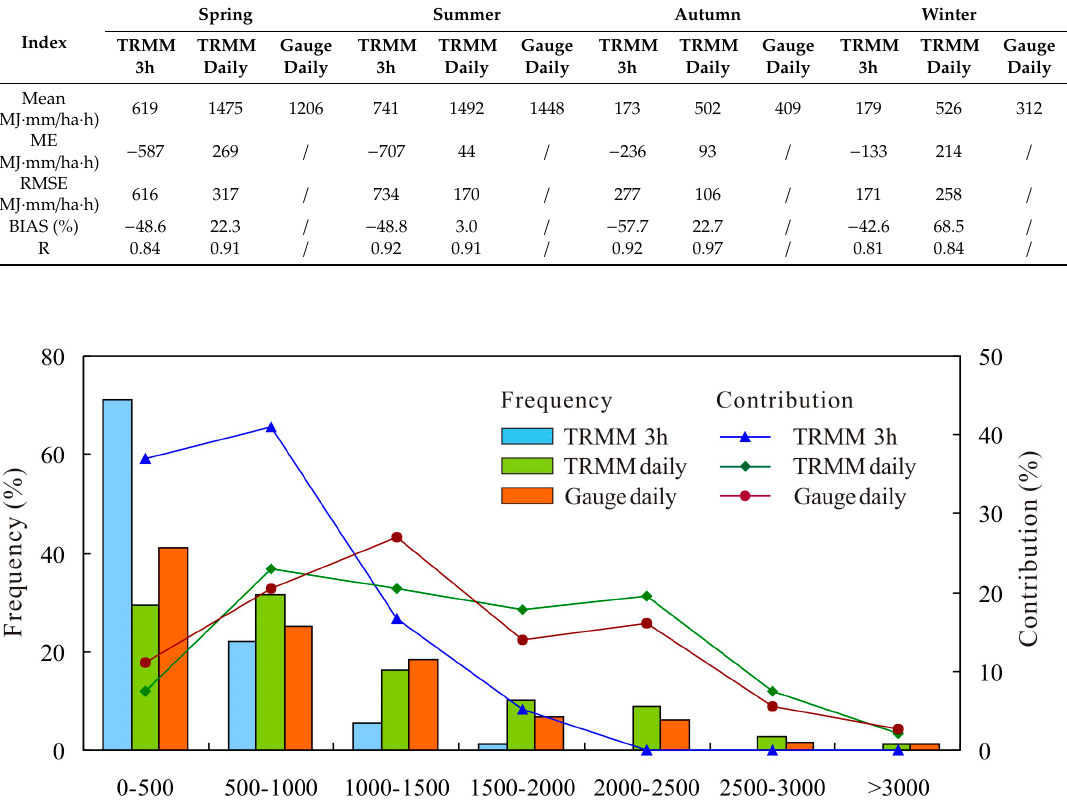
Figure 6. Comparison of annual rainfall erosivity estimated by rainfall data with different temporal resolutions. At the annual scale, the comparison of the ME, RMSE and BIAS of RE estimation from different TRMM rainfall products and rain gauges data are shown in Table 2, and the scatter plots of the RE